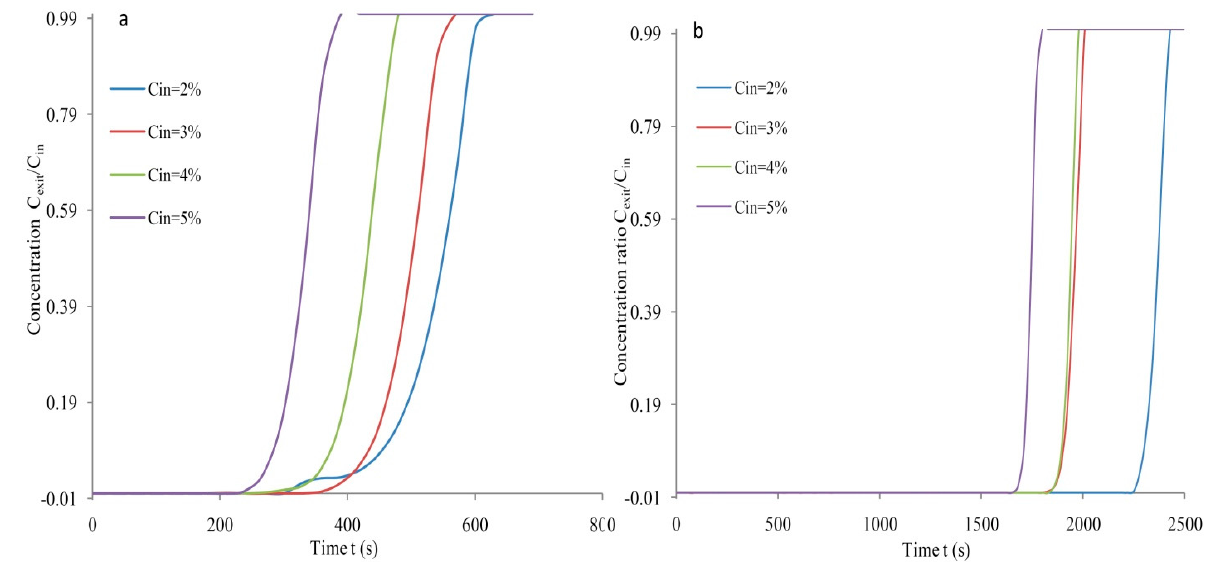
Figure 9. Adsorption response at various CO 2 level at F = 4 lpm, T = 298 K: ( a ) MS-3Å, and ( b ) AC-SY.